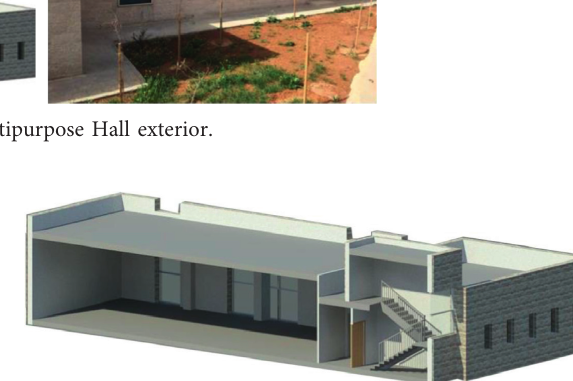
Figure 14: Perspective section of Ras Alain Multipurpose Hall.